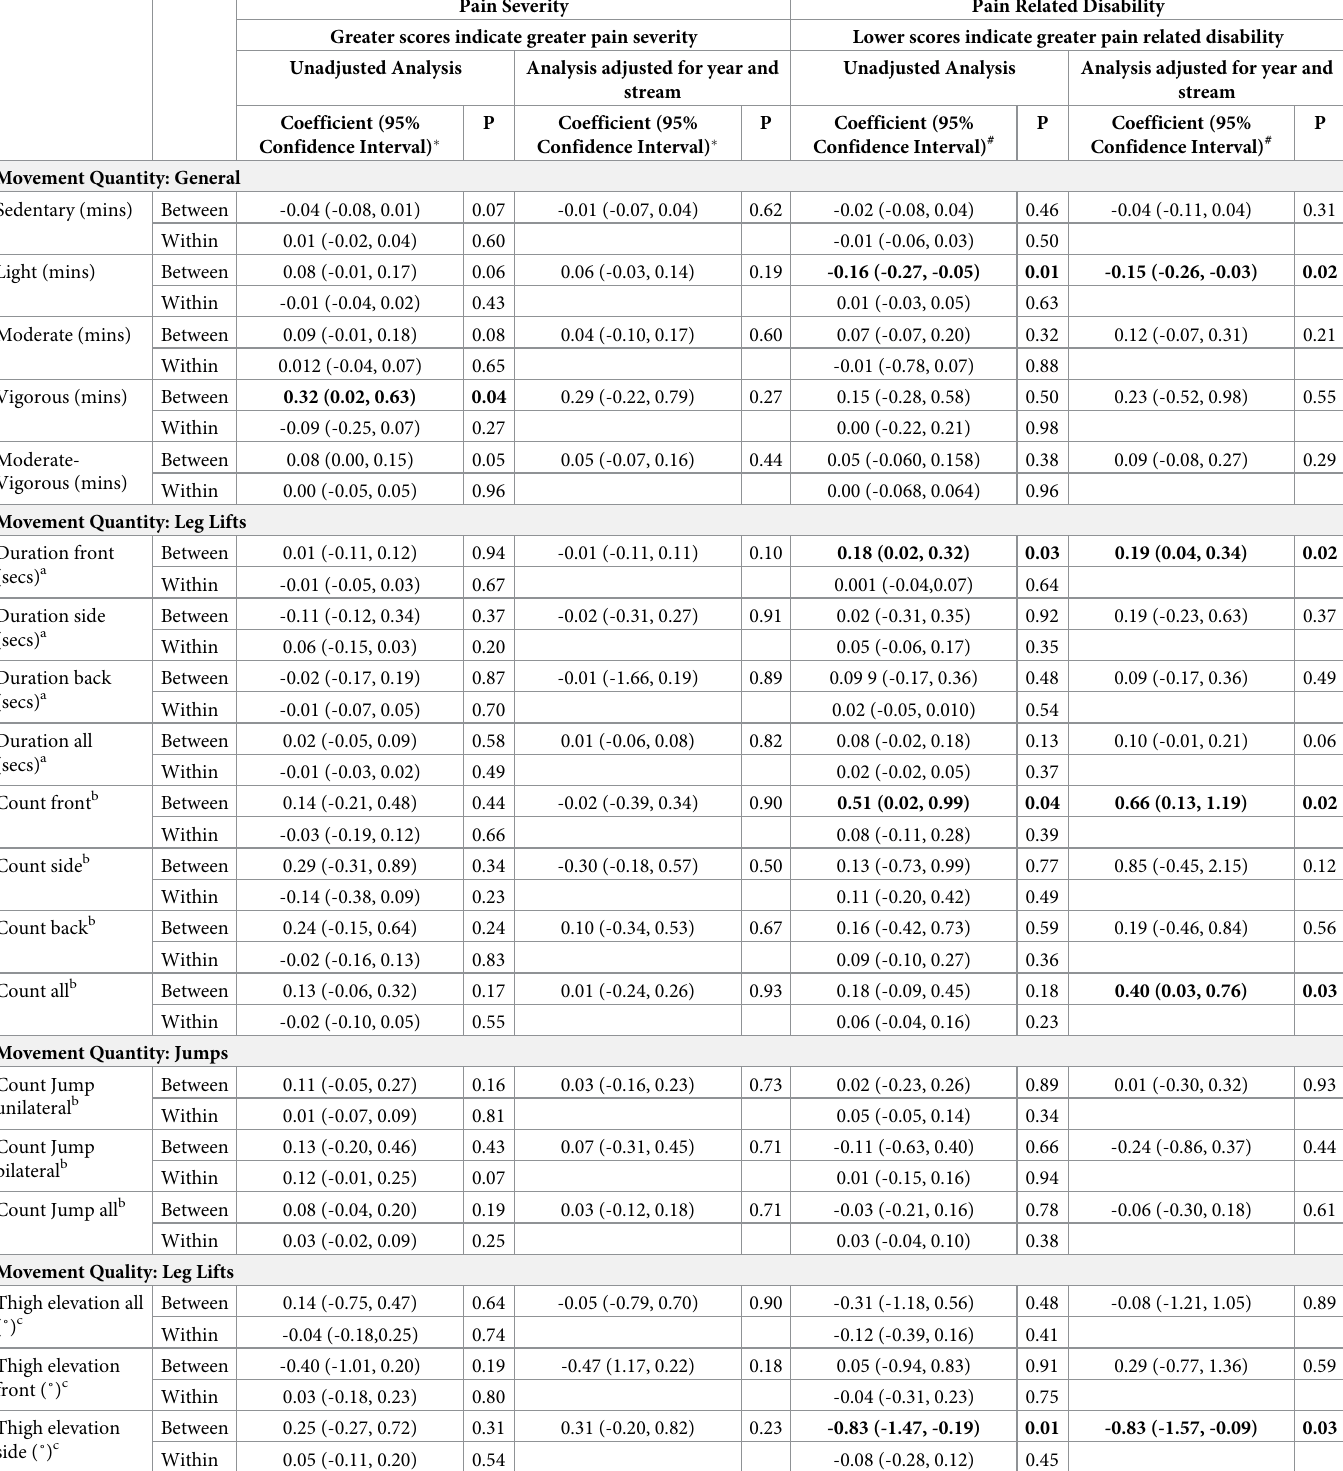
Table 3. Results of linear mixed models examining associations between quantity and quality of movement with pain severity and pain related